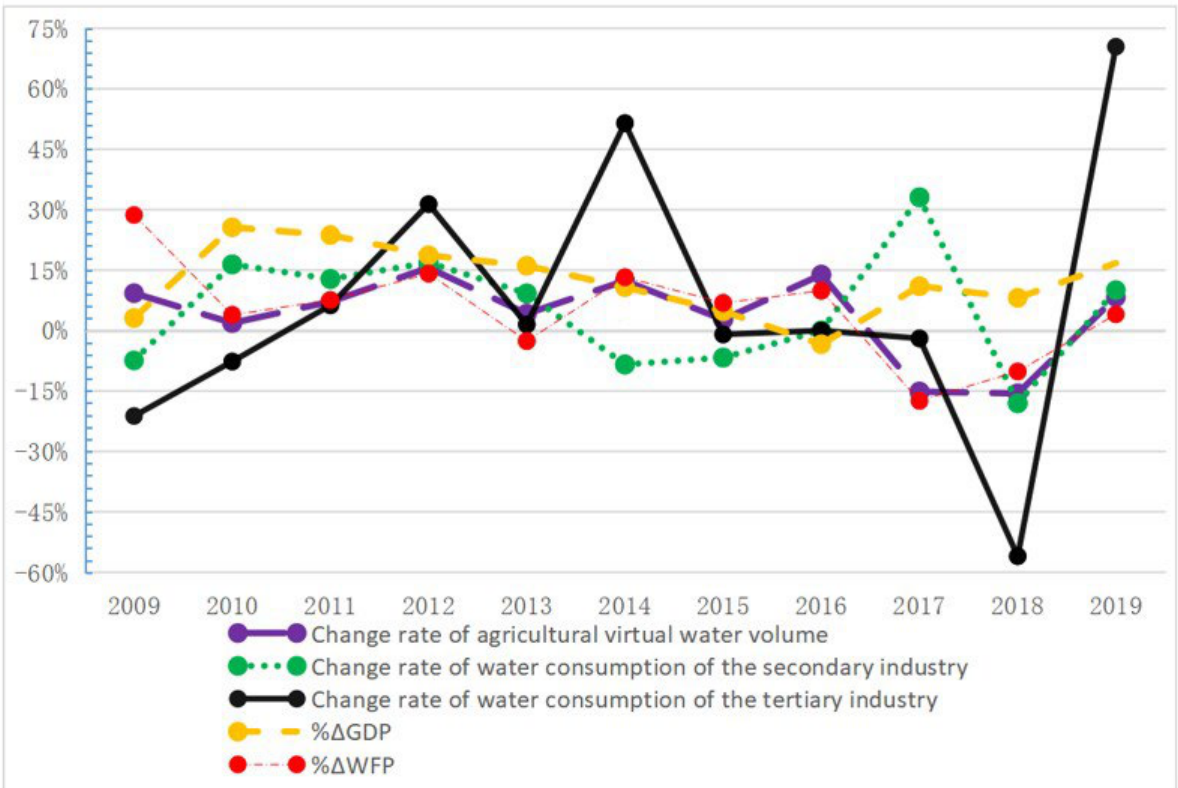
Figure 9. 2008–2019 Change rates of three major industries, GDP , and water footprint in Tarim River Basin. Data source: According to the statistical yearbook of Xinjiang.